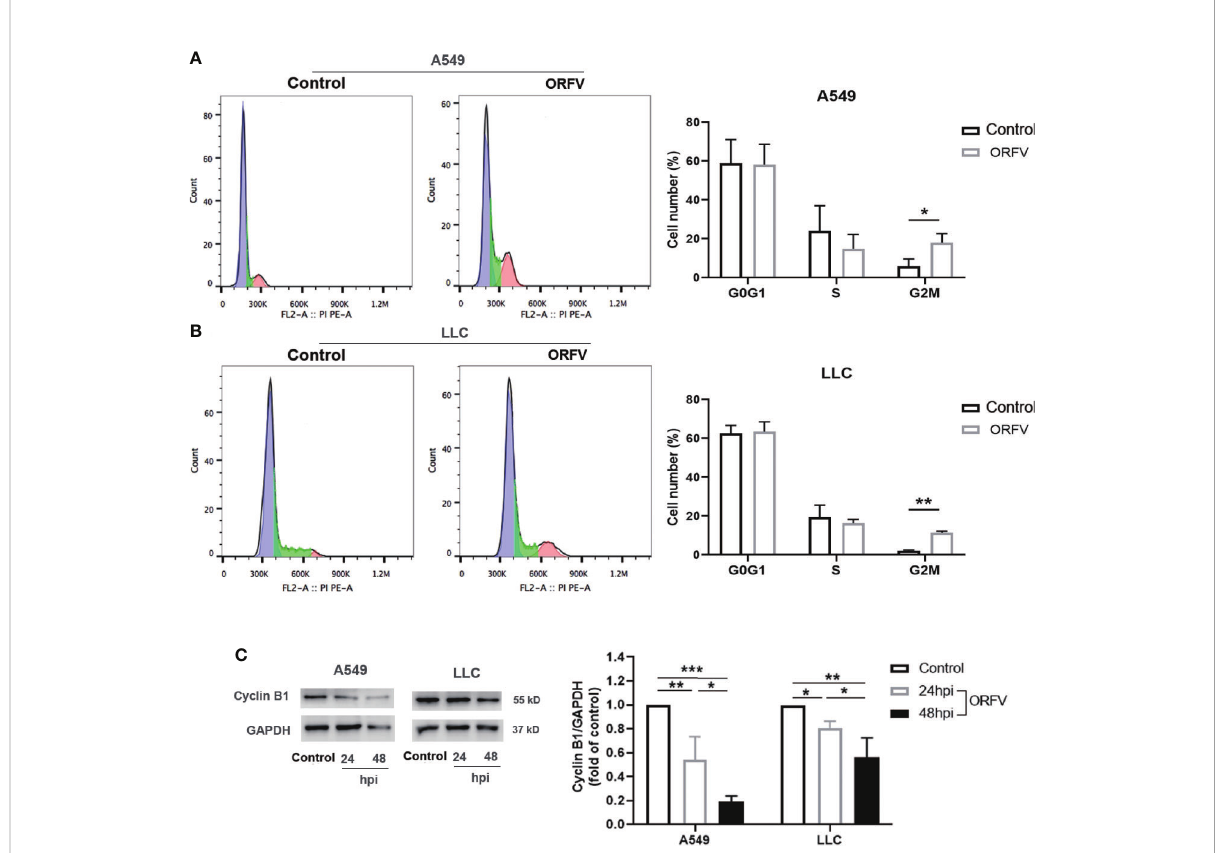
FIGURE 2 ORFV NA1/11 infection induces cell cycle arrest in A549 and LLC cells. (A, B) Flow cytometry analysis revealed that ORFV NA1/11 infection for 24 hours increased the frequency of cells in G2/M-phase, compared with uninfected cells (Control). (C) Western blot analysis of the relative levels of cyclin B1 expression in A549 and LLC cells following infection with, or without, ORFV NA1/11 (MOI 5) for indicated time points. Quanti fi cation was performed using Quantity one software. Data are representative images or expressed as the mean ± SD of each group from three separate experiments. *P<0.05, **P<0.01.